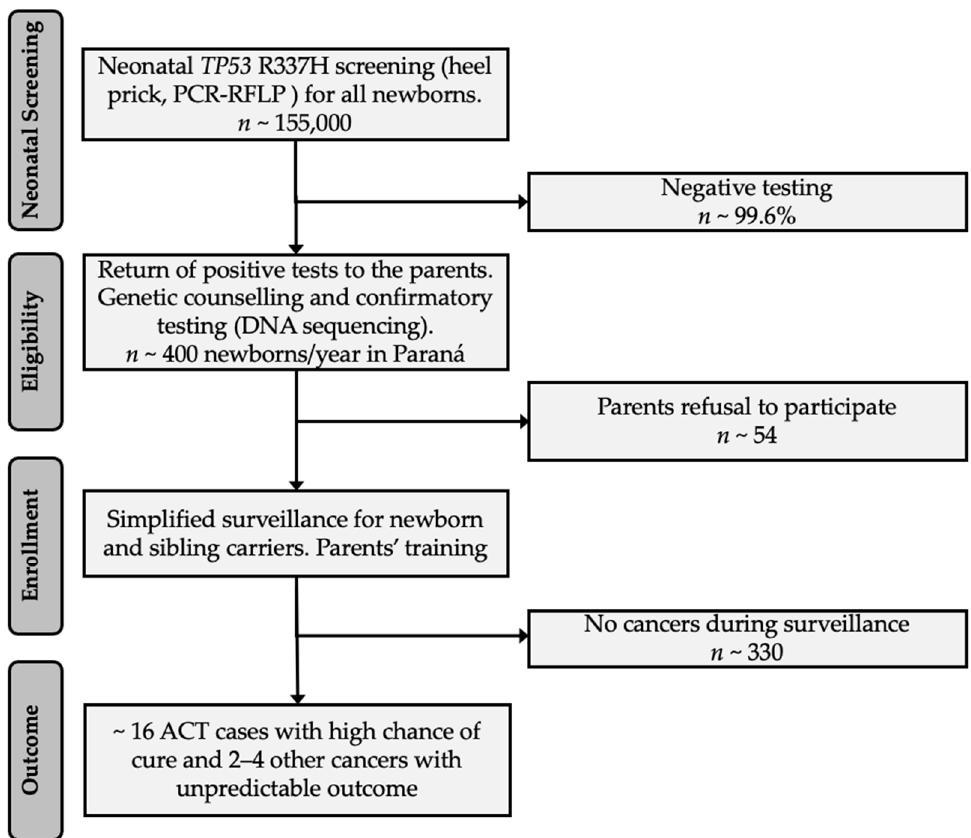
Figure 3. A neonatal and surveillance proposal for the state of Paraná (and state of Santa Catarina with approximately 50% of the projected numbers for Paraná). First step (neonatal screening) expected to be included in the universal Parana and Santa Catarina’s state panel, and provided free of charge. Subsequent steps (eligibility/enrollment) would require the parents’ consent and acceptance to be trained to detect and report early signs and symptoms of ACT.